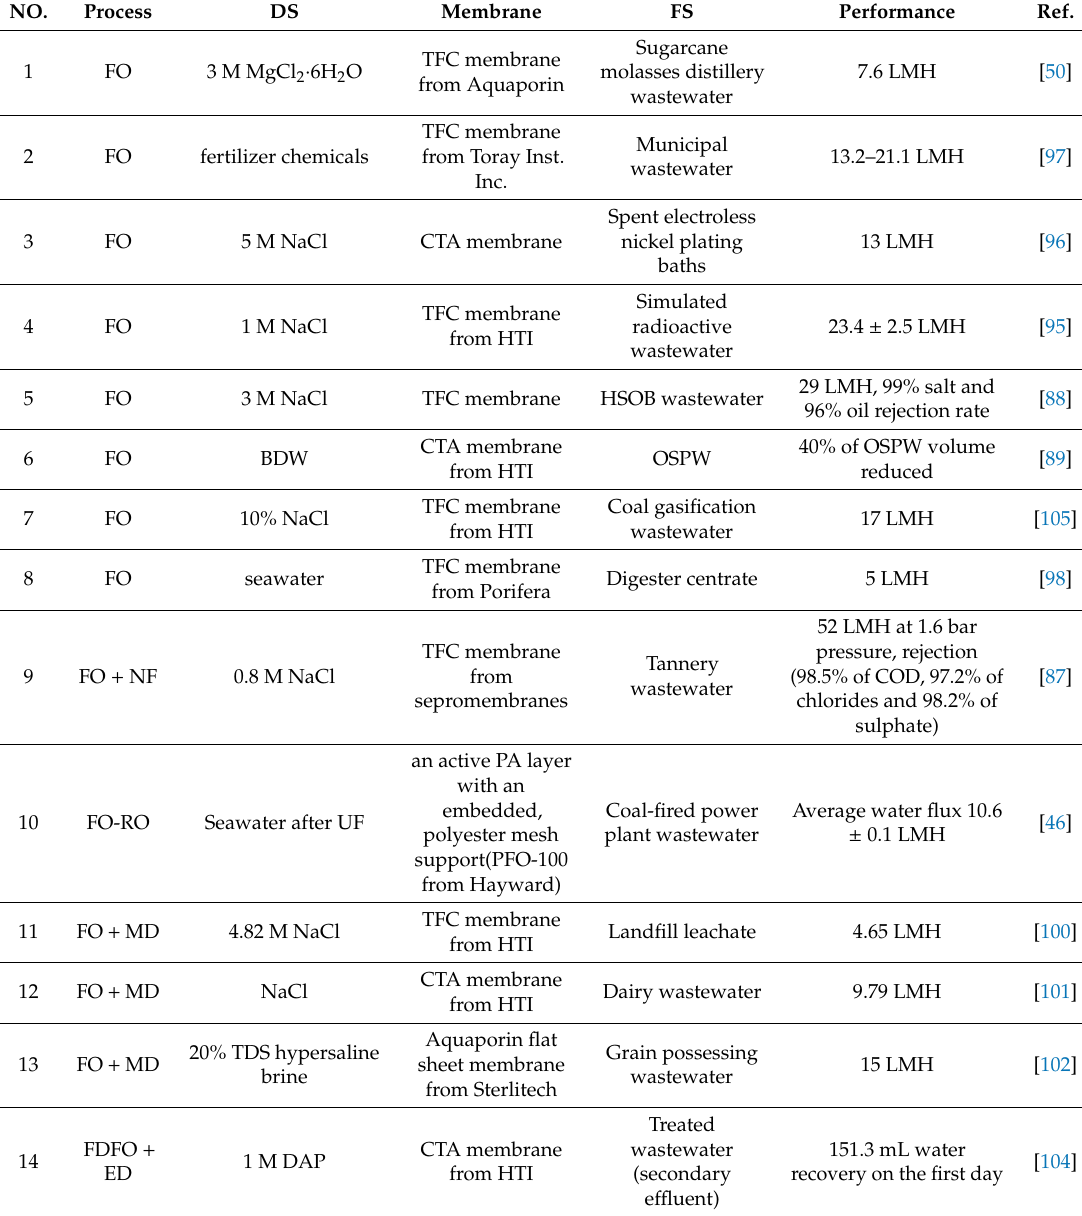
Table 4. Overview of FO and FO based hybrid system pilot